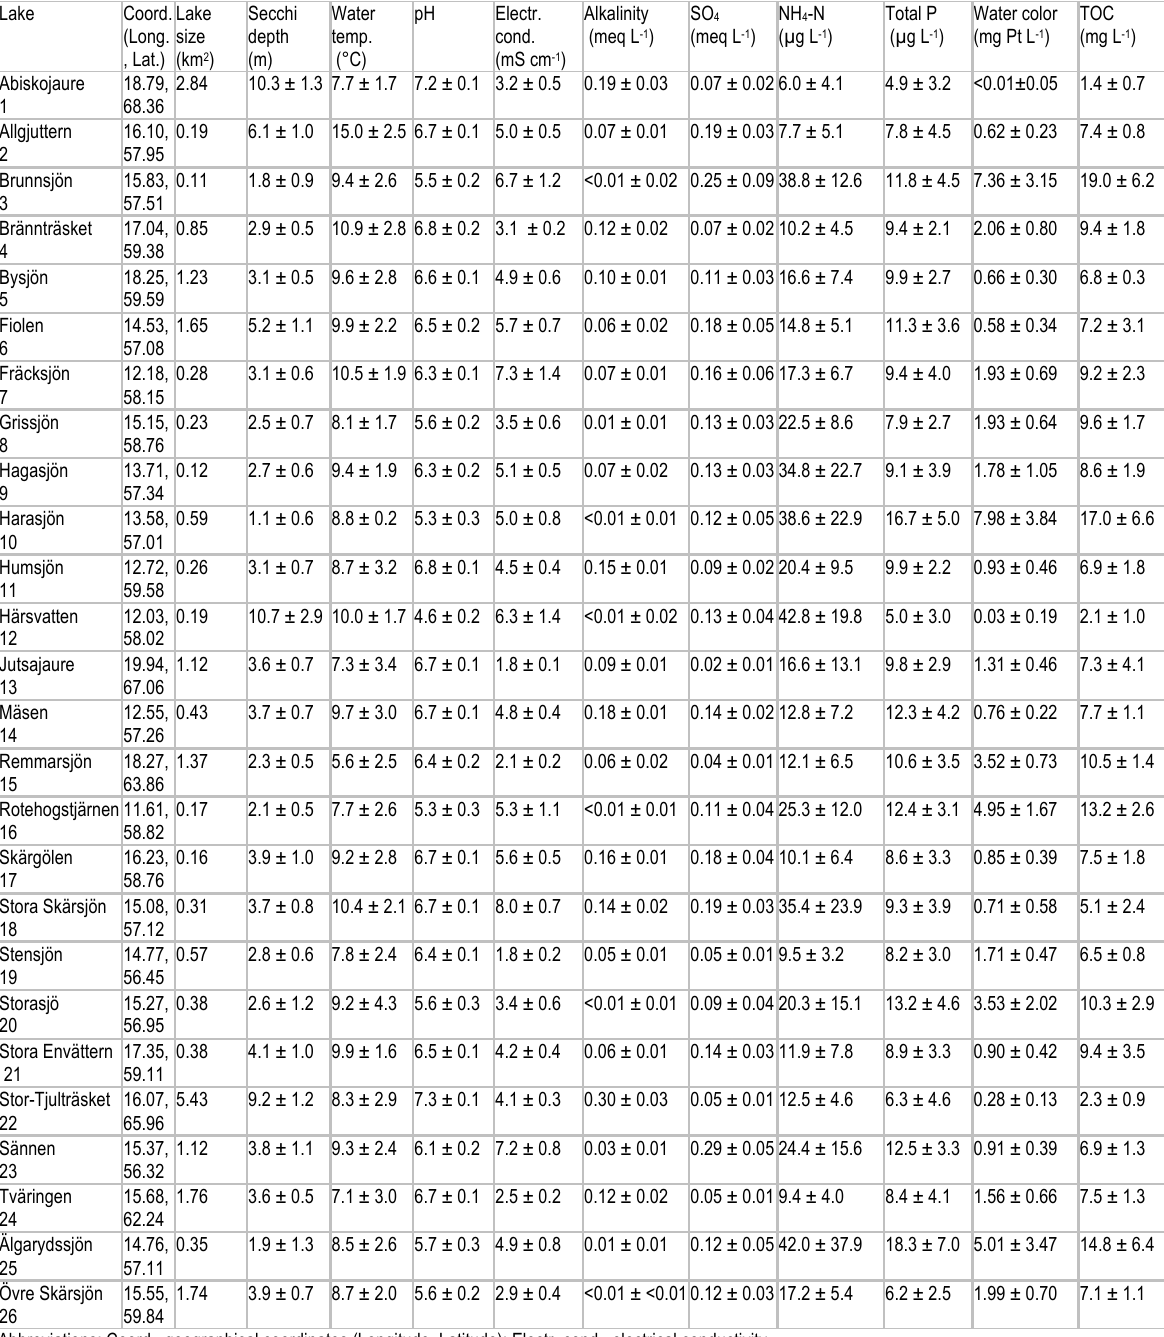
Table 1: Geographical position and limnological variables of study lakes. Shown are the means ± standard deviations between 1988 and 2007 based on a yearly summer sample (n = 20). The number below each lake name makes reference to the lake position in Figure